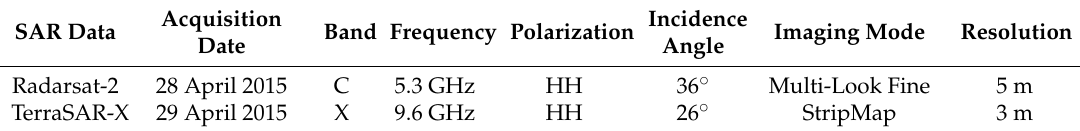
Table 1. Detailed information of the SAR